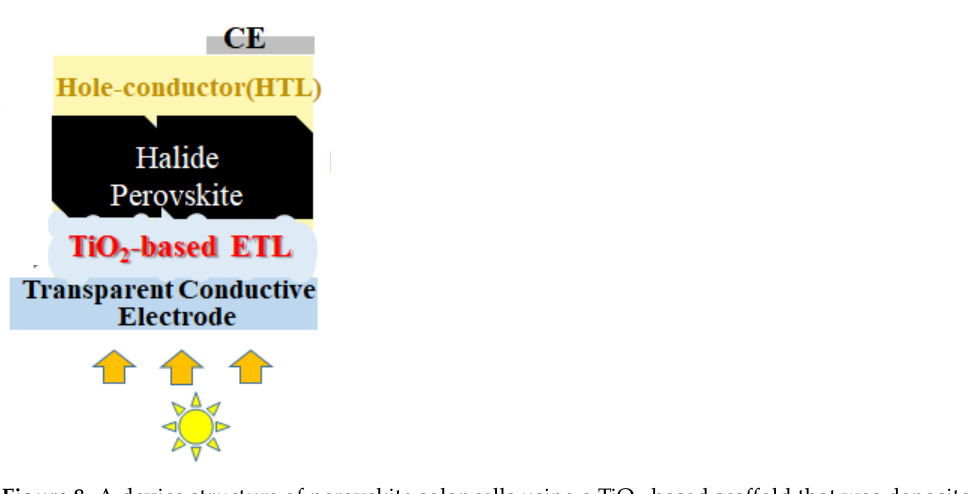
Figure 8. A device structure of perovskite solar cells using a TiO 2 -based scaffold that was deposited on a transparent conductive electrode (FTO). ETL, HTL, and CE denote electron-transport layer, hole-transport layer, and counter electrode (Au), respectively. Table 1. Photovoltaic performance of the perovskite solar cells under a simulated solar light. The best-performing data from the reverse scan were summarized for each device.